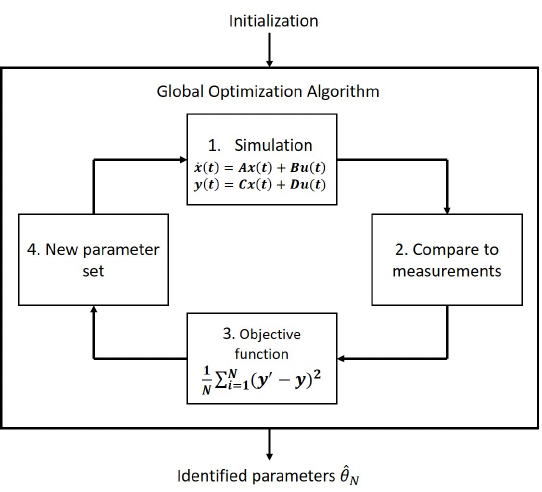
Figure 8. Optimization process. Reproduced from Kramer et al.